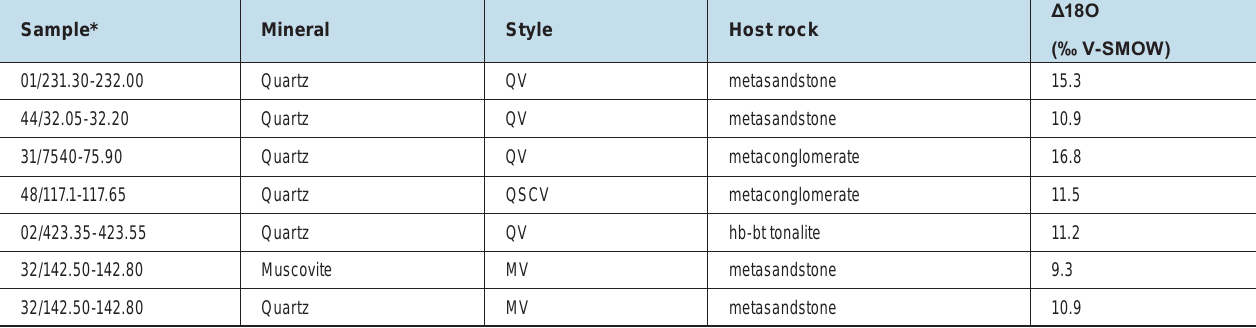
*drill hole number/depth in